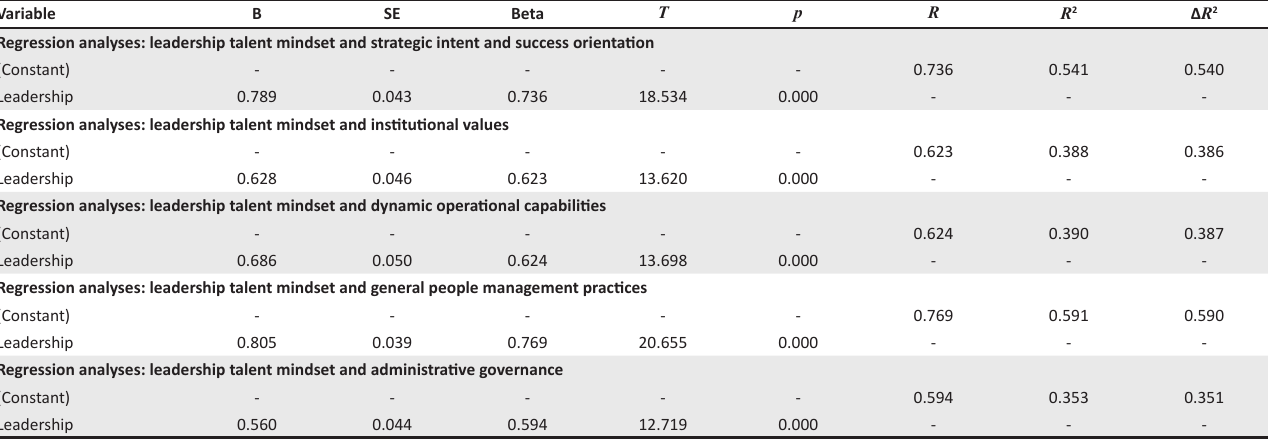
TABLE 3: Regression analyses between leadership talent mindset and organisational talent culture dimensions.